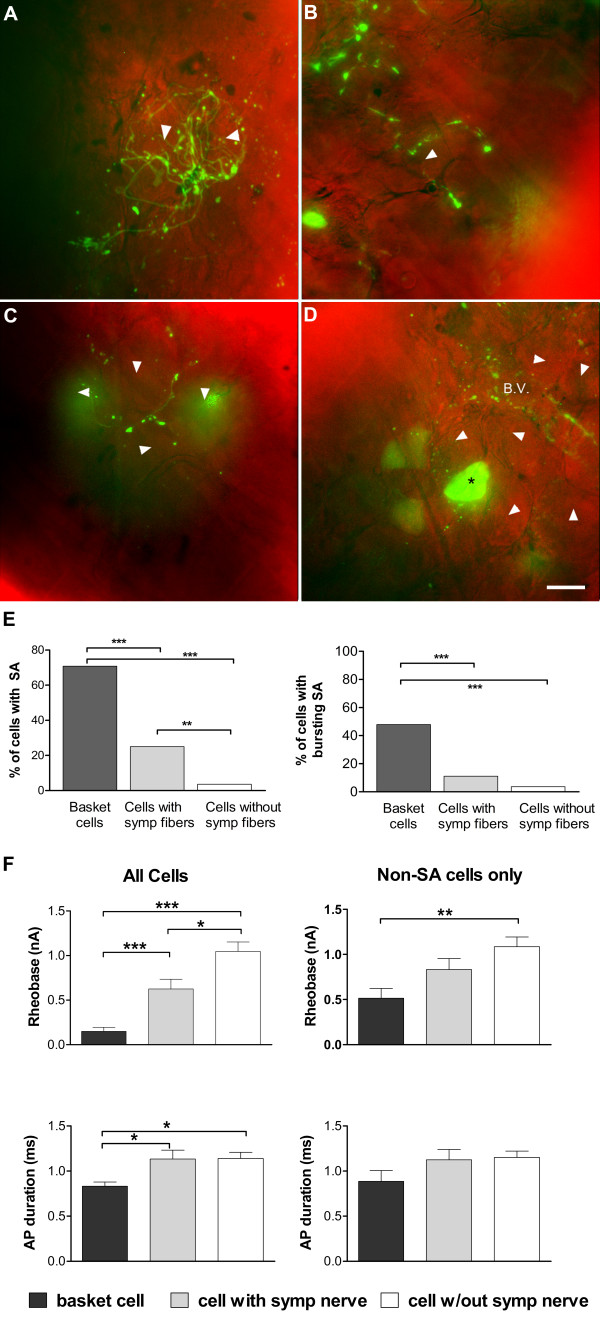
Electrophysiological properties of neurons whose surrounding sympathetic fibers were examined before recording. A - D: arrowheads indicate examples of cells classified has having sympathetic baskets (A) or rings (B) (such cells were combined into a single group of "basket cells"); cells with nearby but less elaborated sympathetic fibers (C); and no nearby sympathetic fibers (D), based on observation of EGFP fluorescence during the recording session. B.V. in (D) indicates a blood vessel. Some small TH-positive neurons are also seen (see text). EGFP fluorescence is shown in green and is from combined layers of a confocal image. Neurons are not counterstained because the images are from live preps used for recording; however, a bright field images of the cells taken in a single plane is shown in the red channel. (E) Basket cells have much higher incidence of spontaneous activity, primarily of the bursting pattern. Overall incidence of spontaneous activity (left), as well as incidence of bursting (right), were significantly higher in basket cells compared to either cells with nearby sympathetic fibers but not making a basket/ring formation, or to cells without any nearby sympathetic fibers (Fisher's exact test). (F) Cells (left) with sympathetic basket formations have lower rheobase (F, top) and shorter AP duration (F, bottom) compared to cells with nearby fibers (not forming a basket or ring) or no nearby fibers; the difference in rheobase is still seen when only non-spontaneously active cells are considered. (ANOVA on ranks with Dunn's post test).